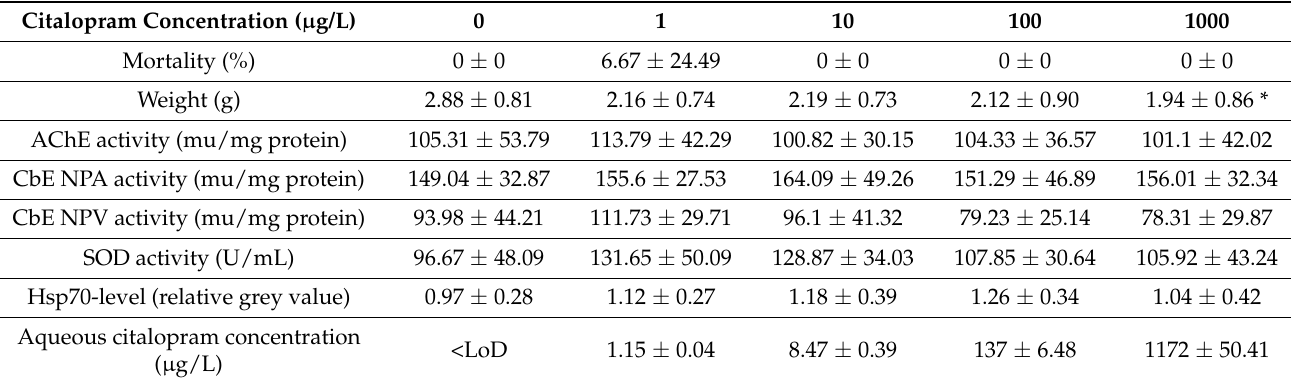
Table 1. Results obtained in the experiment with citalopram.